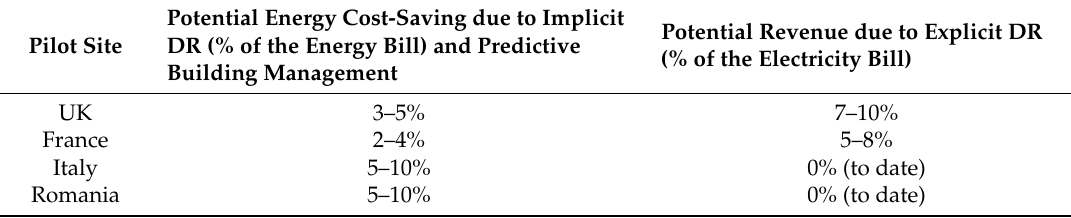
Table 6. Estimated ranges of cost-saving and revenue for participation in DR and predictive building